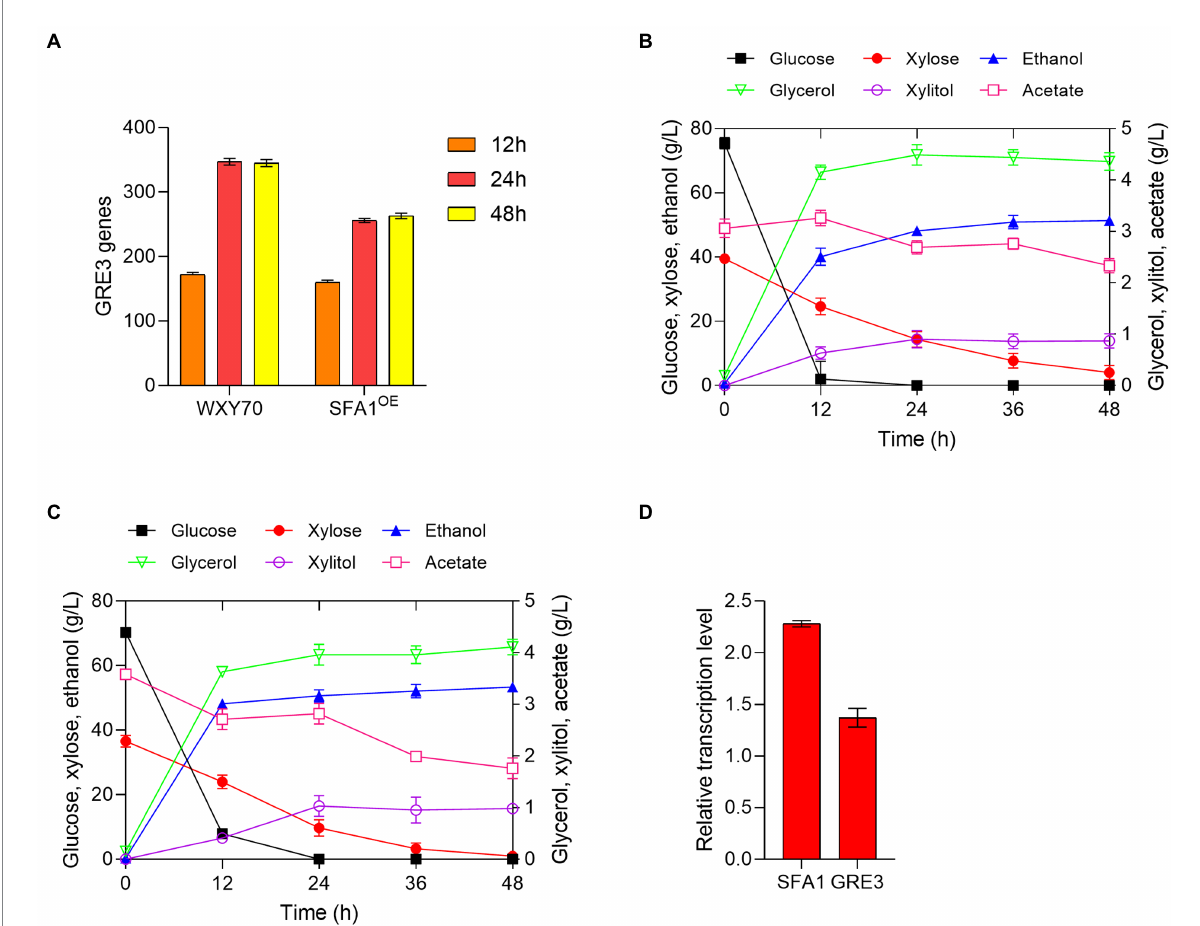
FIGURE 1 Analysis of transcript levels of engineered strains and fermentation in simulated corn stover hydrolysate solution. (A) Amount of GRE3 genes in strains WXY70 and SFA1 OE . Fermentation profiles of the parental strain WXY70 (B) , GRE3 OE (C) in simulated corn stover hydrolysate within 48 h. (D) The transcriptional level analysis of SFA1 OE and GRE3 OE strains overexpressed